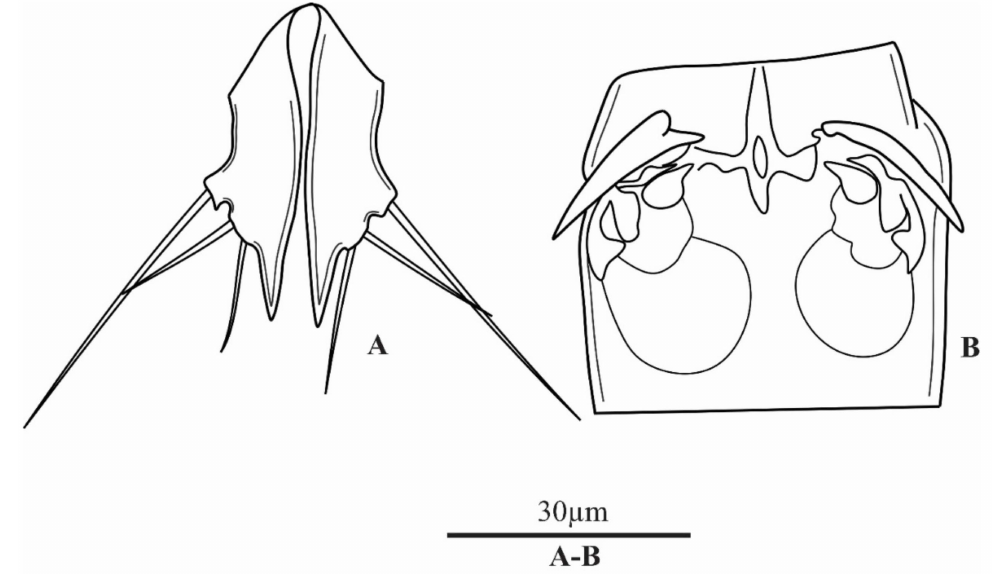
Figure 14. Parastenocaris vugiaensis sp. nov. female. ( A ), P5; ( B ), P6 and genital